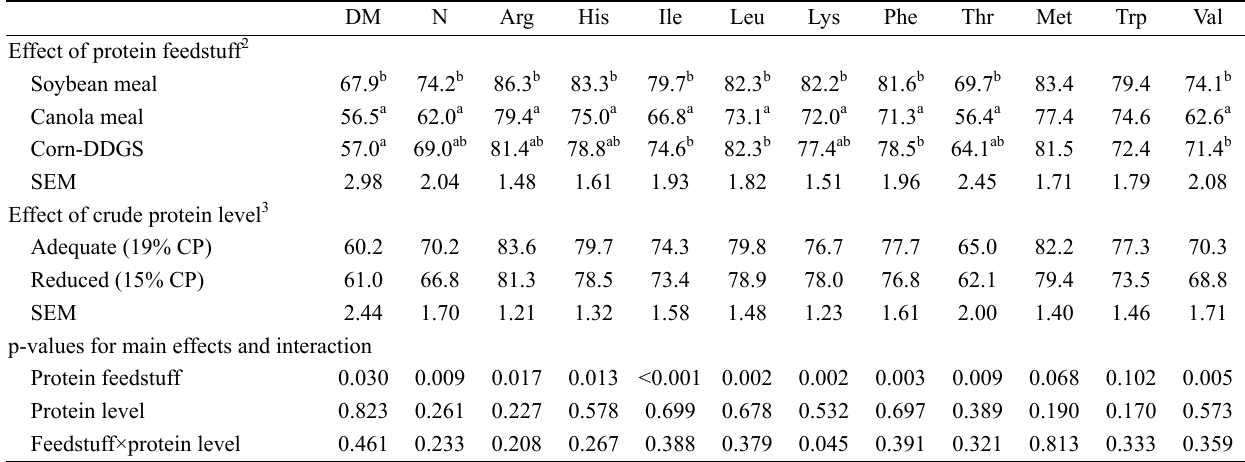
Table 4. Dry matter digestibility and apparent ileal digestibility (%) of nitrogen and indispensable amino acids in growing pigs in response to protein feedstuff used and crude protein level